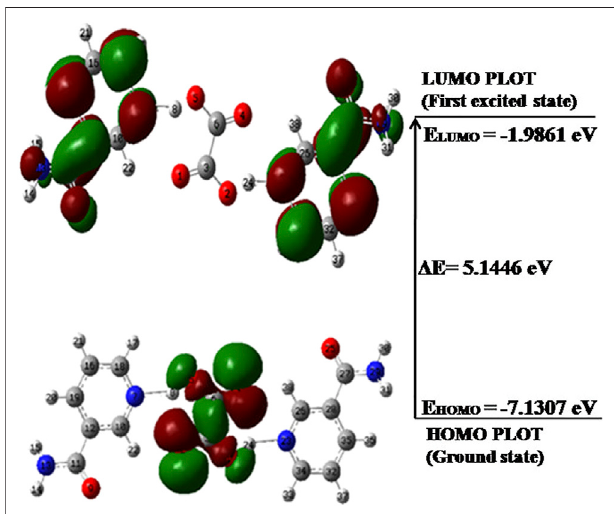
FIGURE 5 | HOMO-LUMO energy gap of NIC – OXA salt with orbitals participating in electronic transitions. HOMO, highest occupied molecular orbital; LUMO, lowest unoccupied molecular orbital; NIC – OXA, nicotinamide – oxalic acid.